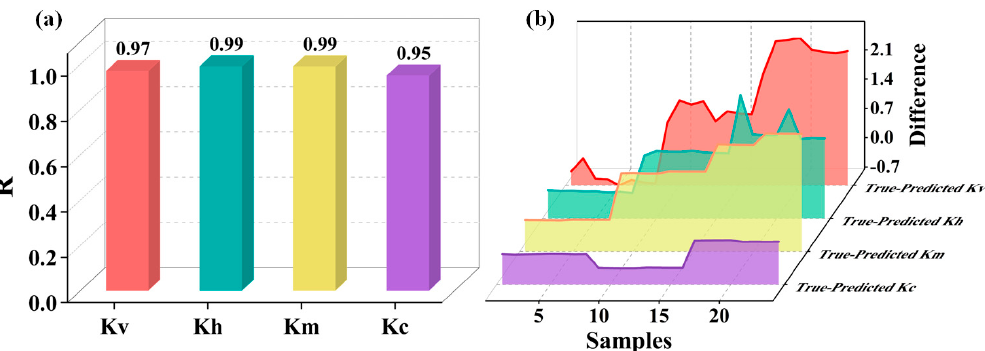
Figure 14. Independent verification of model feasibility: ( a ) Evaluation of four foundation stiffness coefficient models using R; ( b ) Consistency of foundation stiffness calculated by FE model and DT model.